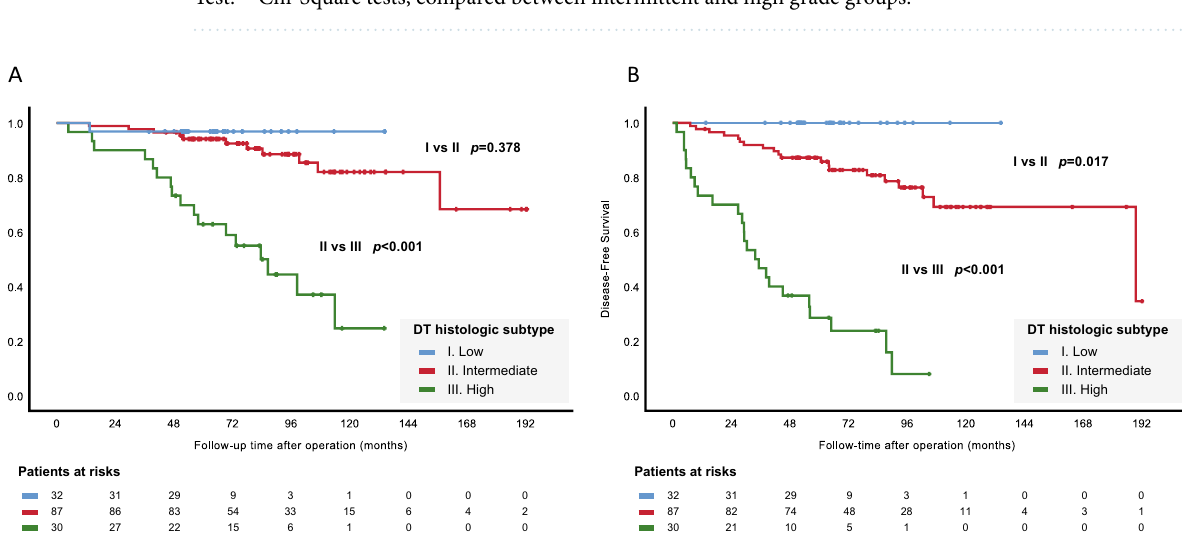
Table 2. Association between survival and IASLC/ATS/ERS classification of dominant tumor (DT). *ANOVA Test. **Chi-Square tests, compared between intermittent and high grade groups.